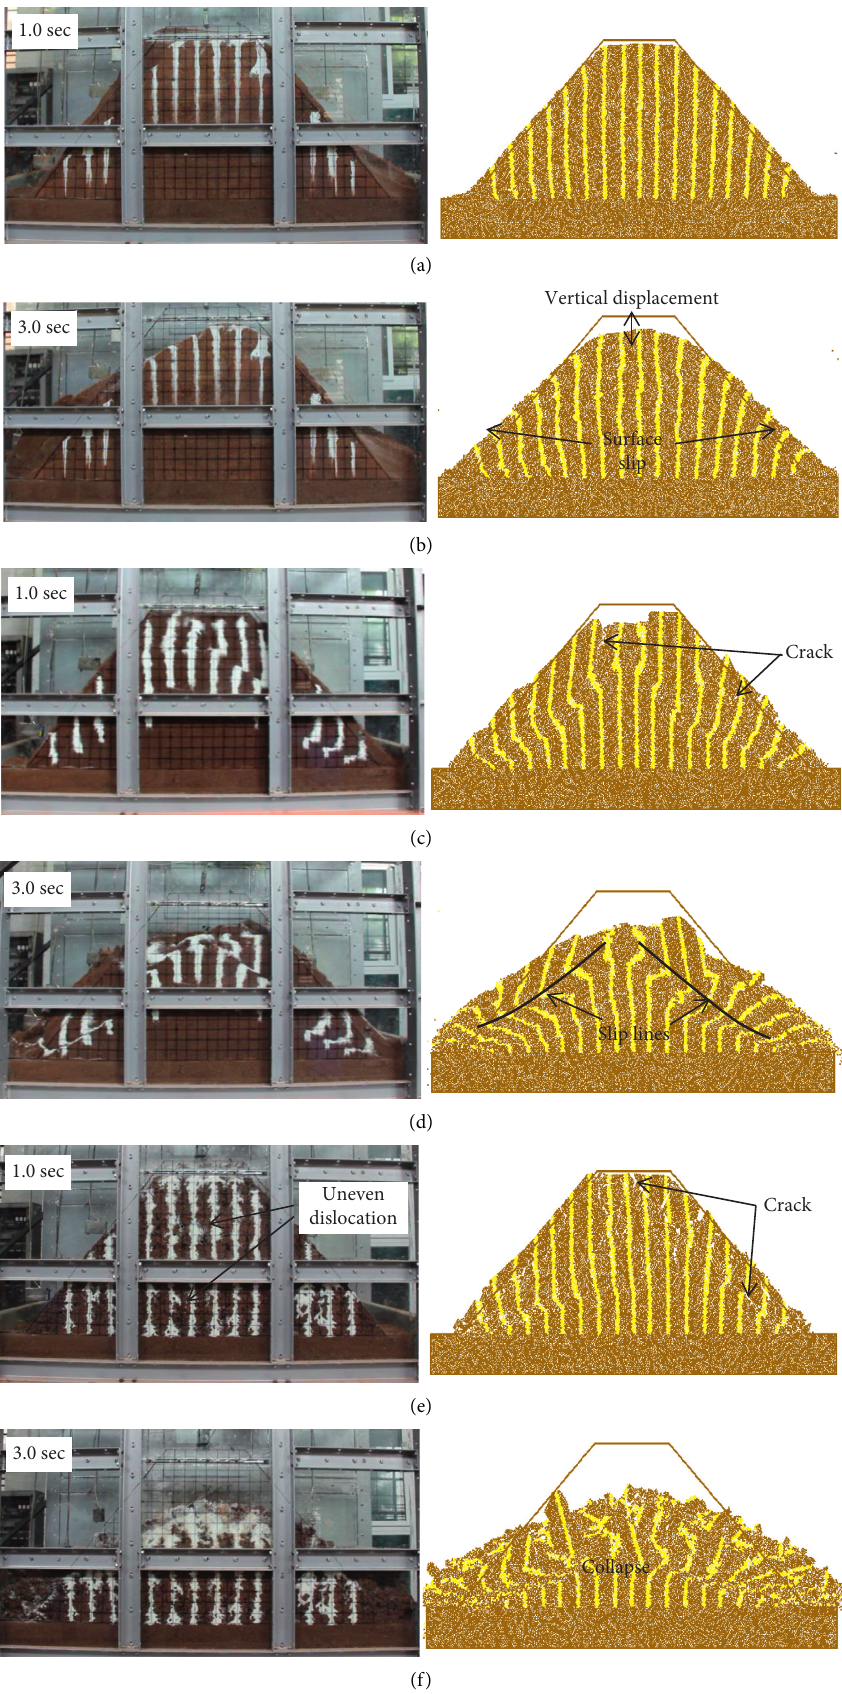
Figure 5: Comparison of results by model test and numerical simulation. (a) Failure when loading 1 s (5% moisture content). (b) Failure when loading 3s (5% moisture content). (c) Failure when loading 1s (8% moisture content). (d) Failure when loading 3s (8% moisture content). (e) Failure when loading 1s (12% moisture content). (f) Failure when loading 3s (12% moisture